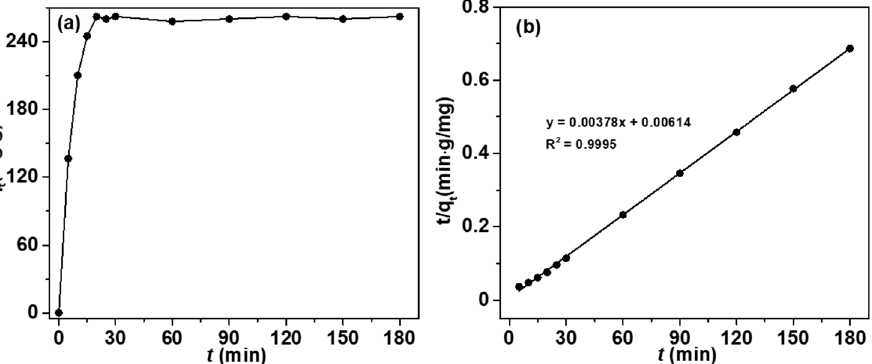
Figure 7. ( a ) Adsorption kinetic curves of the NUT-21-TETA for Pb 2+ removal, ( b ) the pseudo-second-order kinetic plot for the adsorption (C 0 = 500 mg/L, m = 100 mg, V = 200 mL, T = 25 °C). From the practical application point of view, the recyclability of adsorbents is the most critical property. The effect of pH on the Pb 2+ removal of the NUT-21-TETA (Figure S2) indicates that an excellent combination exists between the NUT-21-TETA and Pb 2+ at pH 6.1, but less affinity at a low pH is indicated, meaning that the Pb 2+ desorption of the NUT-21-TETA could be realized at a low pH. For instance, the NUT-21-TETA can be regenerated and reused for the Pb 2+ trap by rinsing it with 0.1 M HCl. To examine the cycling stability of the NUT-21-TETA, an adsorption–desorption cycle was repeated five times, and the removal efficiency was still higher than 90%. As presented in Figure S4, no obvious decrease of Pb 2+ uptake was observed during the adsorption–desorption recycles. These